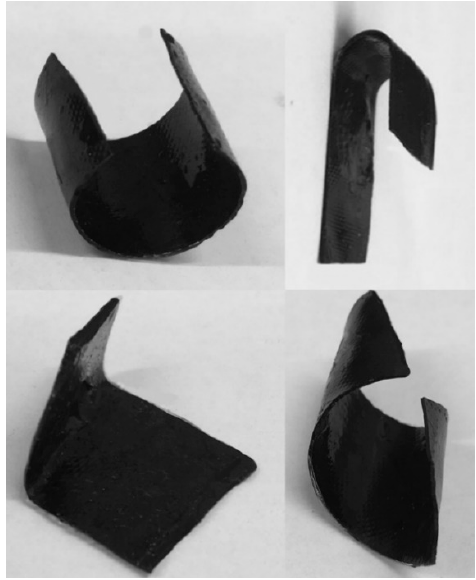
Figure 6. Different shapes of the MWCNT nanopaper/epoxy composites manipulated by hand after Figure 6. Di ff erent shapes of the MWCNT nanopaper / epoxy composites manipulated by hand after composite Joule heating to 70 °C and cooling below the T g temperature of 53.9 °C to form new shapes. composite Joule heating to 70 ◦ C and cooling below the T g temperature of 53.9 ◦ C to form new